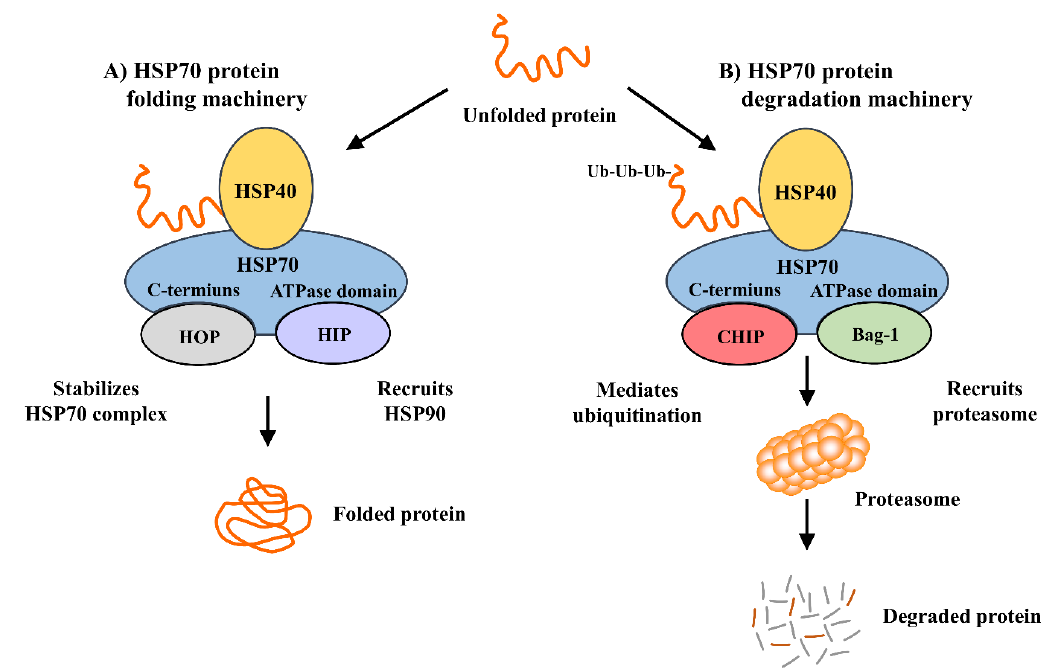
Figure 1. HSP70 chaperone machinery. HOP and CHIP compete for HSP70’s C-terminus during protein folding and degradation, while HIP and Bag-1 compete for the ATPase domain. Depending on the site of HIP or Bag-1 binding, HSP70 may lead to protein folding (HIP / HOP pathway; ( A ) or to protein degradation through the proteasome (CHIP / Bag-1 pathway; ( B ). Ub = ubiquitin.